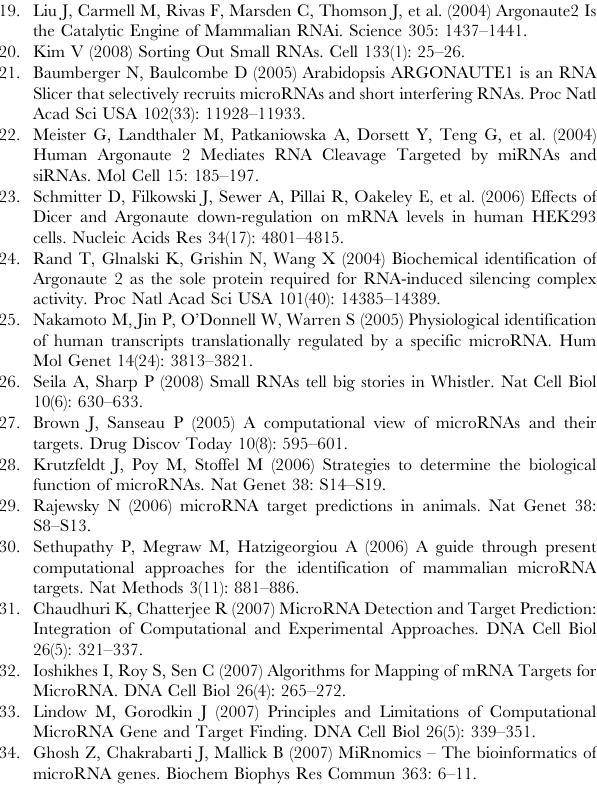
Dataset S1 Data and statistical codes. Expression data and supporting R codes for Stanhope et al (2009) ‘‘Statistical use of Argonaute expression and RISC assembly in microRNA target